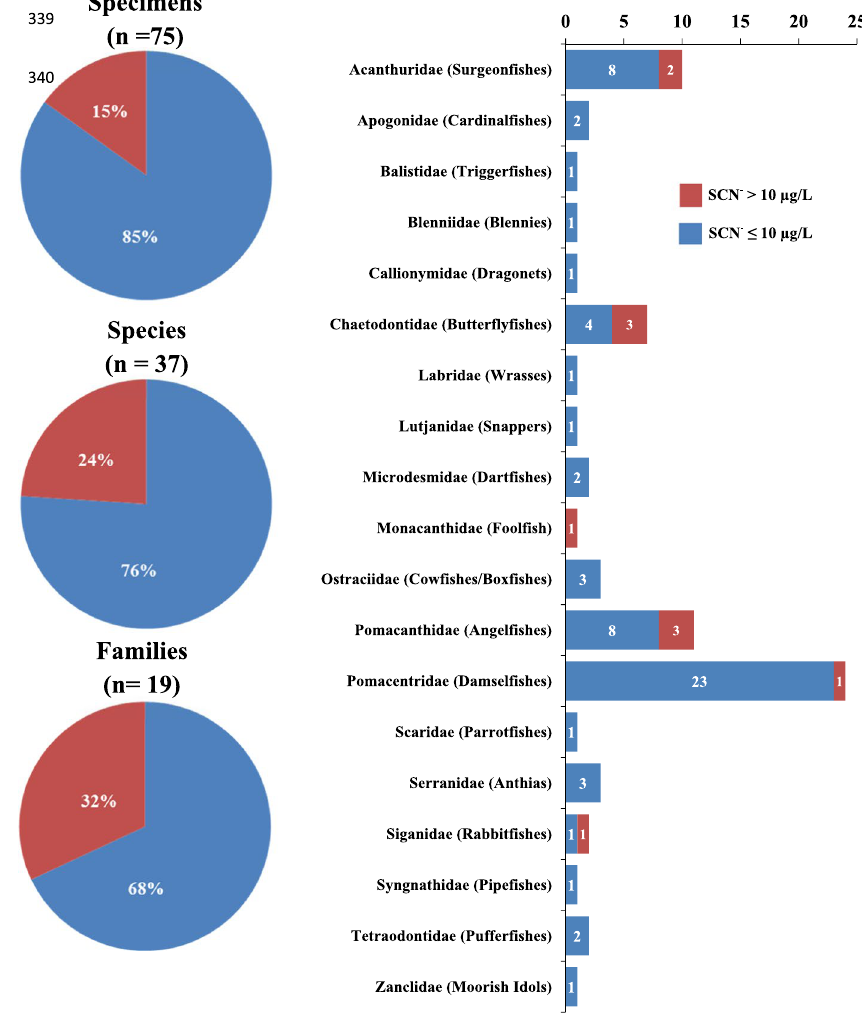
Figure 1. Percentage of reef fish specimens, species, and families (pie charts) and number of specimens per fish family (bar chart) displaying concentrations of SCN − > 10 µ g/L in the water at the end of the depuration period (24